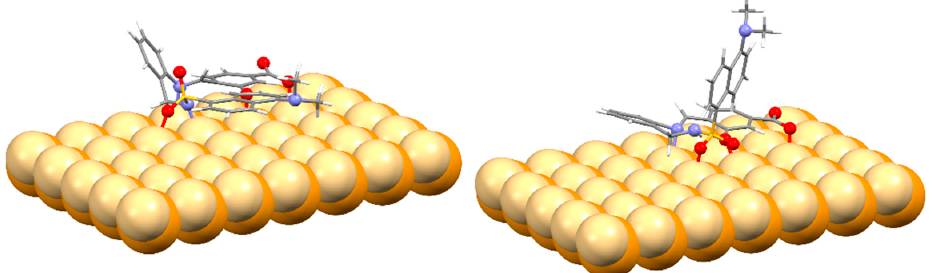
Figure 11. DFT models for the H 3 L–NMs interaction.